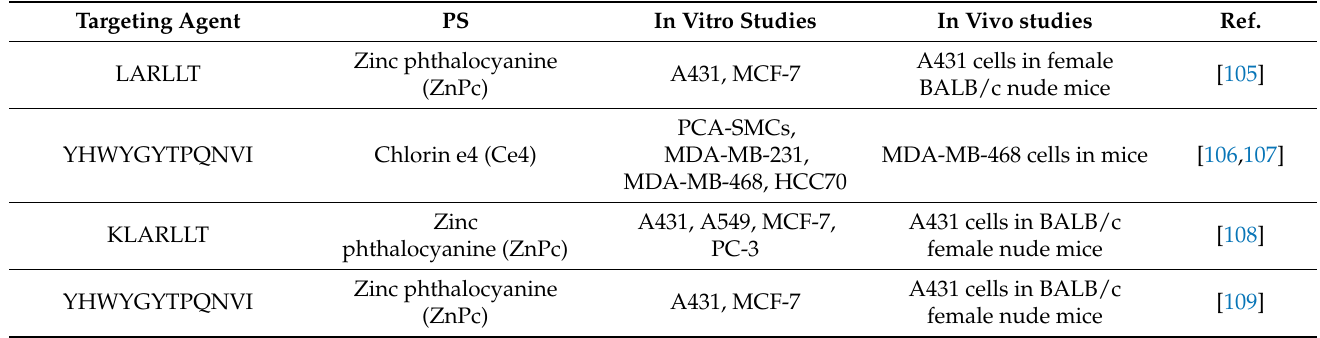
Table 3. EGFR-targeted PDT performed with anti-EGFR